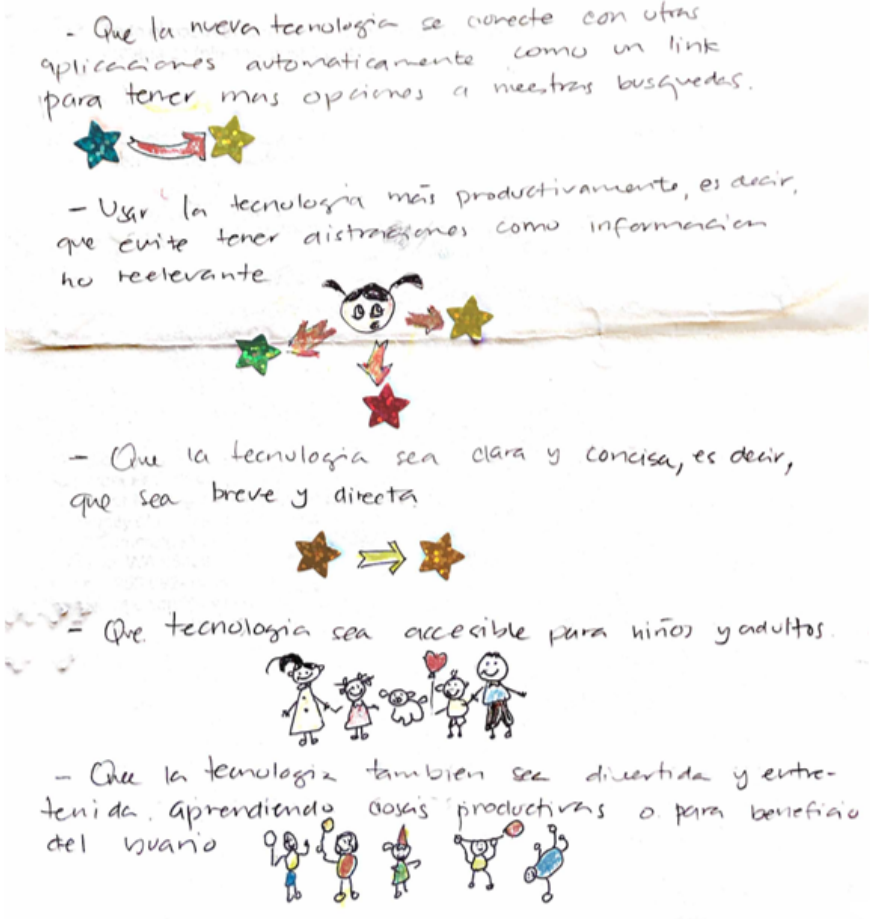
Figure 2. Example design artifact from a Latino parent. Technology ideas for self-care: new technology connects with other apps automatically to have more search options; use technology productively, without distractions or irrelevant information; have clear and concise information; technology should be accessible for children and adults; and technology should be fun and entertaining.